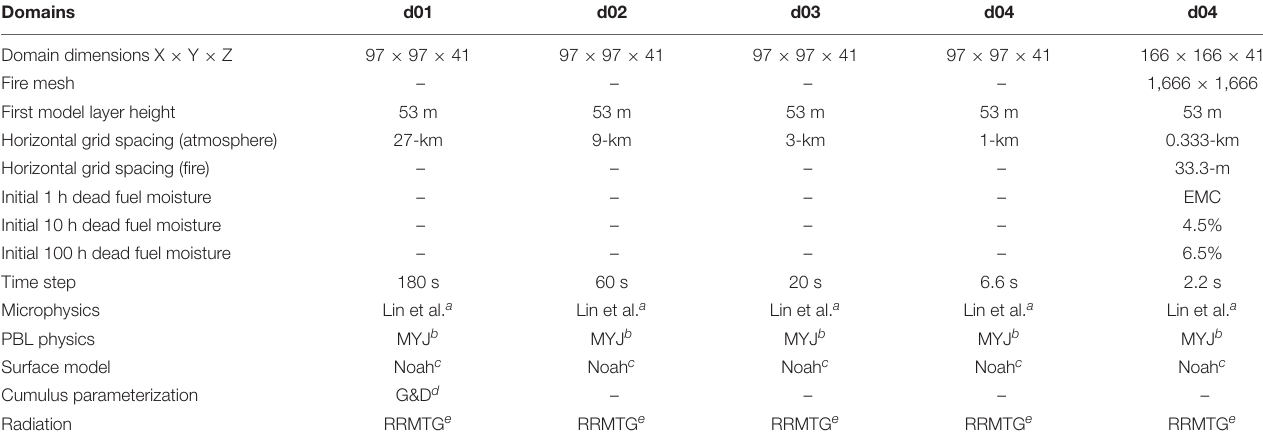
TABLE 2 | Detailed Weather Research and Forecast model (WRF) configurations for the WRF-SFIRE simulations of the Pioneer Fire. Domains